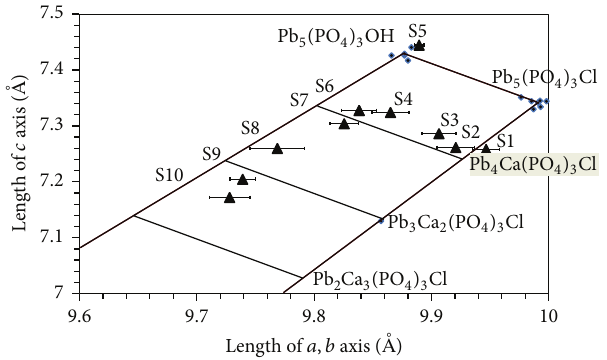
Figure 6: Unit cell graph for synthetic apatites S1–S10.